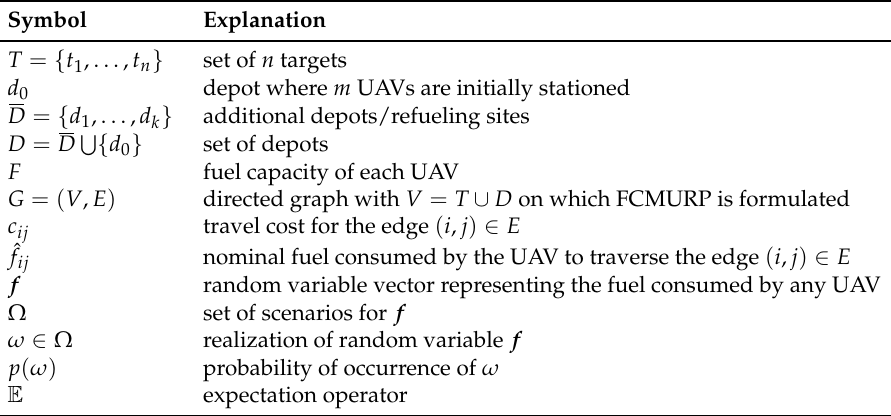
Table 1. Table of